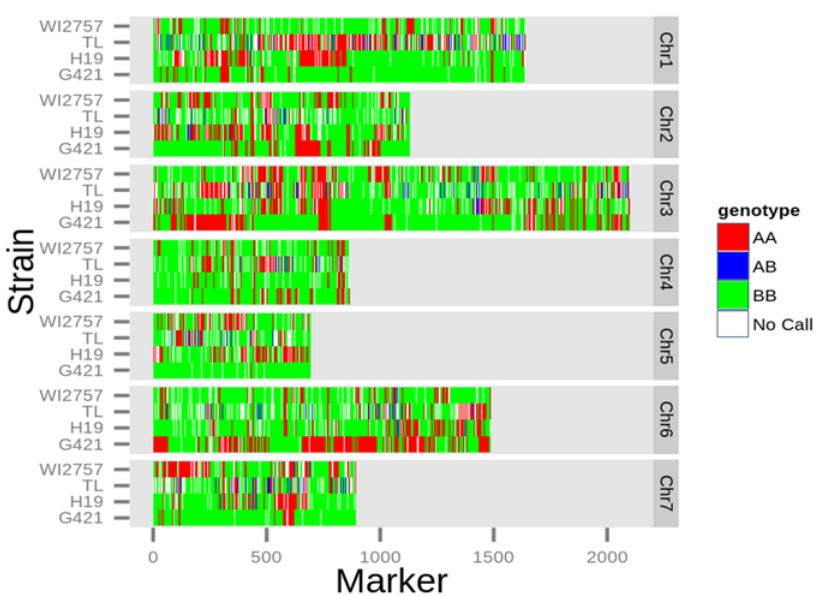
Fig 6. Application of cucumber genotyping array to four cucumber accessions. Genomic DNA of four cucumber accessions — H19, TL, G421, and WI 2757 — was hybridized on the cucumber array. The genotype calls of the array were plotted as heatmap per chromosome where A is the ‘ 9930 ’ allele and B is the ‘ Gy14 ’ allele. The mixed color blocks illustrate the polymorphic property of the SNPs on the array.